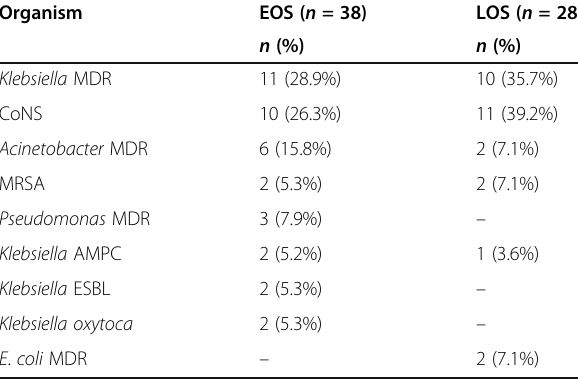
Table 4 Distribution of organisms according to onset of